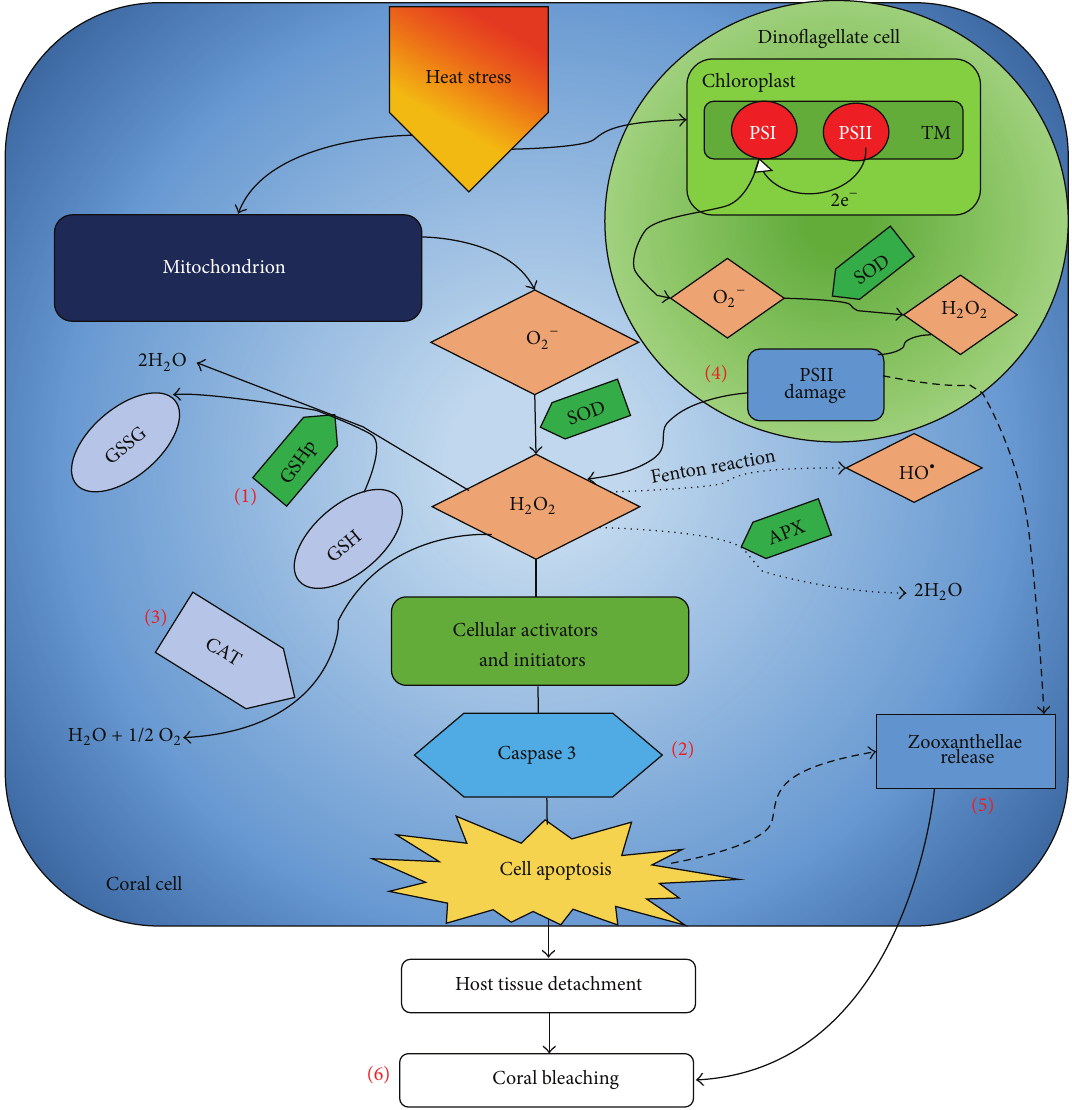
Figure 1: Model of oxidative stress induced by heat stress in corals leading to bleaching events. Blue shapes stand for measures carried out in the study, using the following methods: total glutathione quantitation (1), caspase 3 (2) and catalase (3) activities measurements, PAM fluorometry (4), zooxanthellae density estimation (5), and visual bleaching monitoring (6). PSI: photosystem I; PSII: photosystem II; TM: thylakoid membrane; O 2− : superoxide anion; H 2 O 2 : hydrogen peroxide; HO ∙ : hydroxyl radical; SOD: superoxide dismutase; CAT: catalase; GSHp: glutathione peroxidase; GSH: glutathione; GSSG: glutathione disulphide; APX: ascorbate